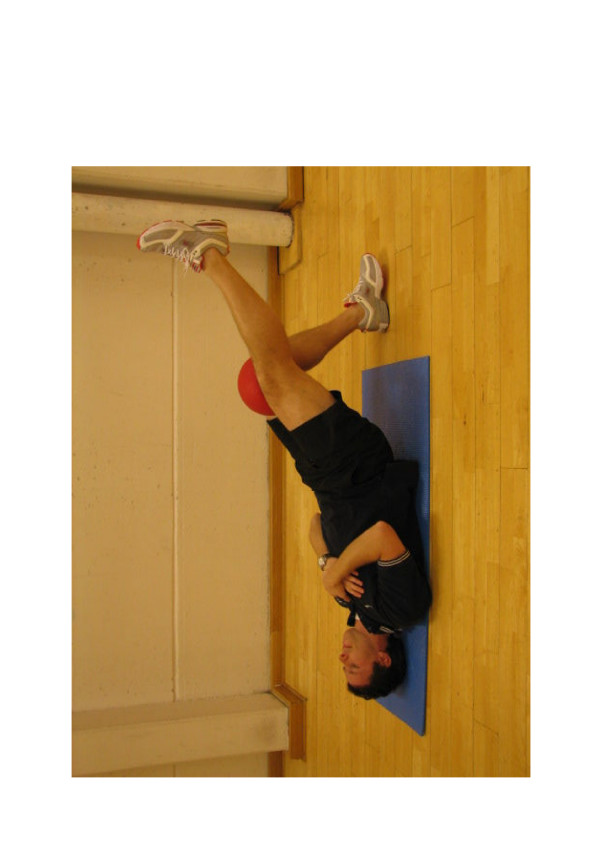
Core control while lifting pelvis and lower back on single leg with simultaneous contraction of hip adductors and buttocks.